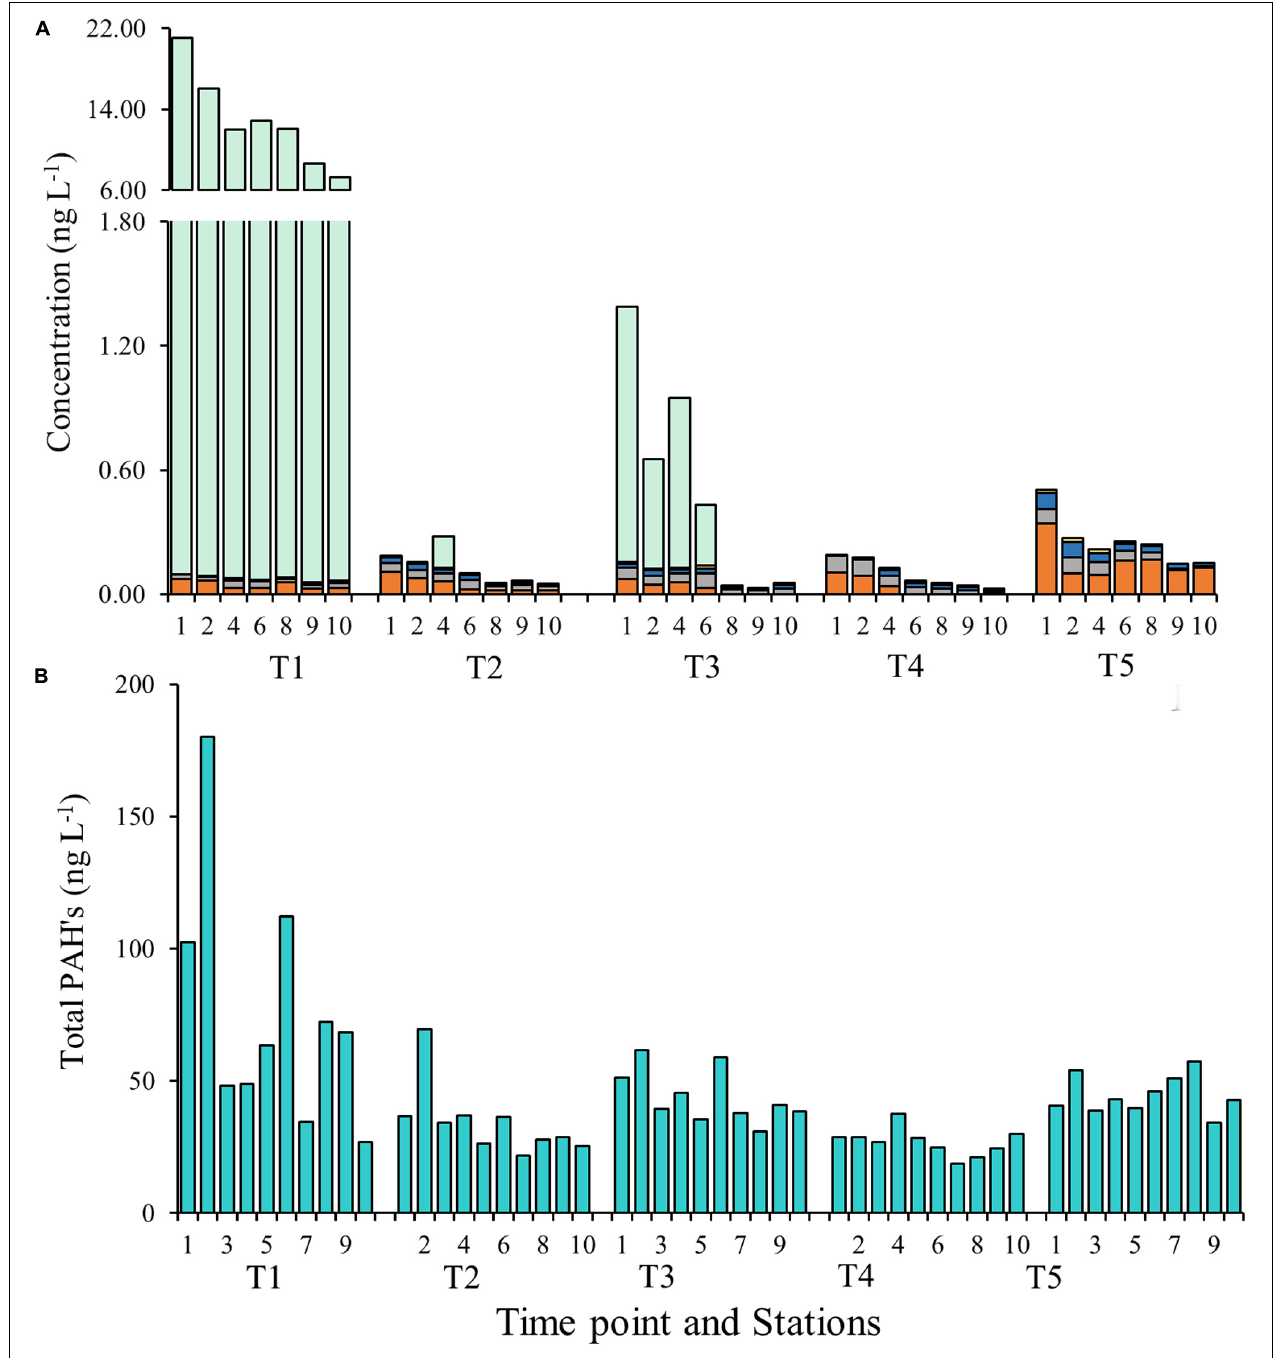
FIGURE 8 | (A) Concentrations of pharmaceuticals and biocides at each time point and station. The y -axis on the left corresponds to the imidacloprid (orange), carbamazepine (gray), cotinine (blue), and carbamazepine-epoxide (yellow) and the y -axis on the right corresponds to Prednisone (green). (B) Concentrations of polycyclic aromatic hydrocarbons (PAHs) at each time point and at each